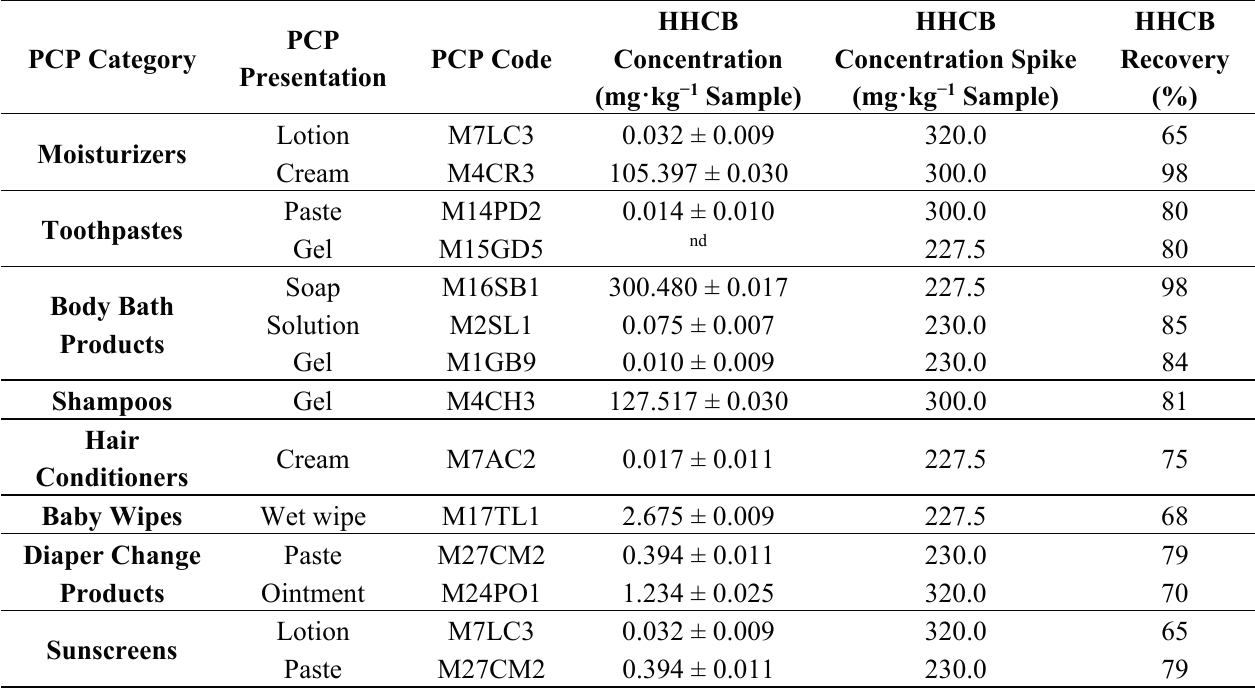
Table 3. Selected personal care products (PCP) for the recovery assays of each PCP category, respective galaxolide (HHCB) concentrations, HHCB spikes, and recoveries